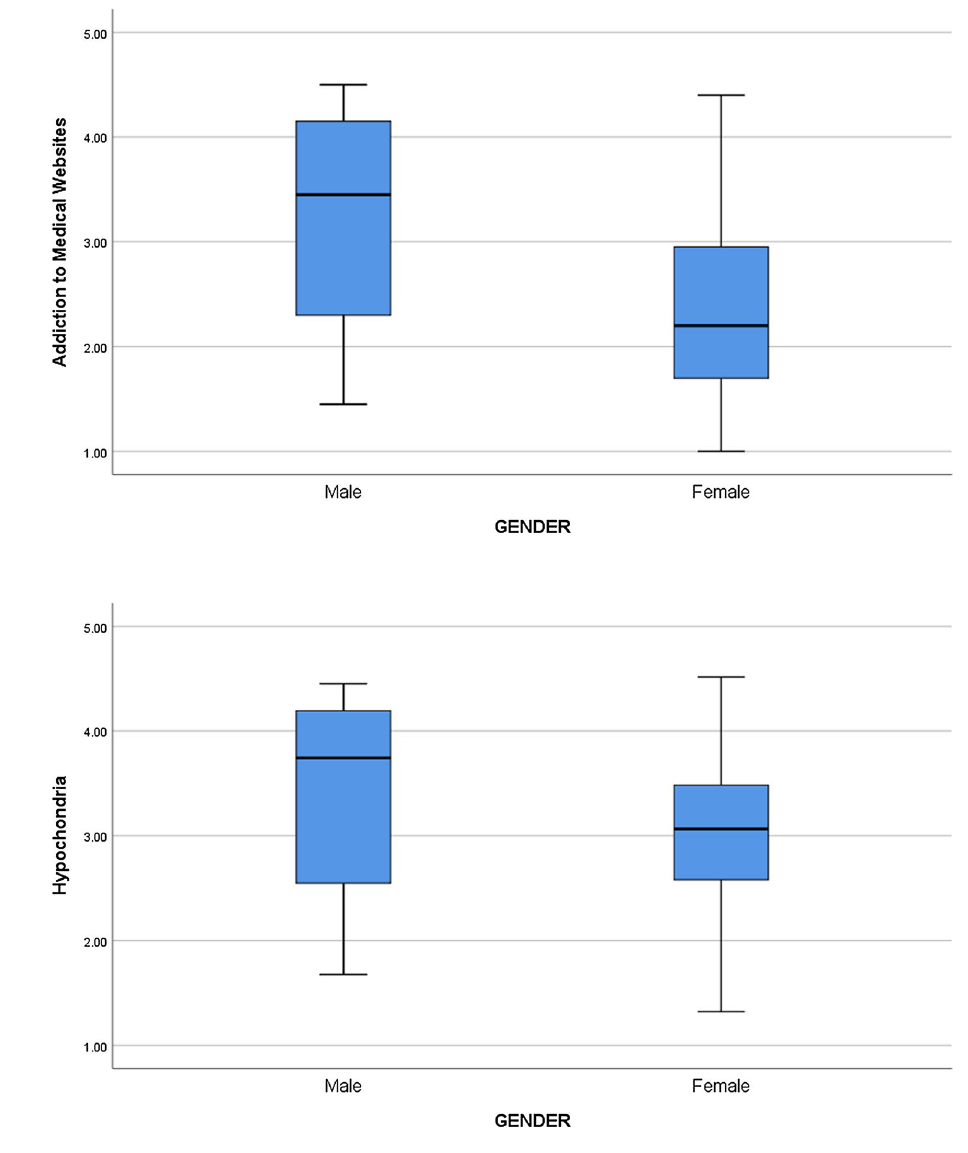
Fig. 2 Boxplot of the means and SDs of addiction to medi- cal websites based on gender